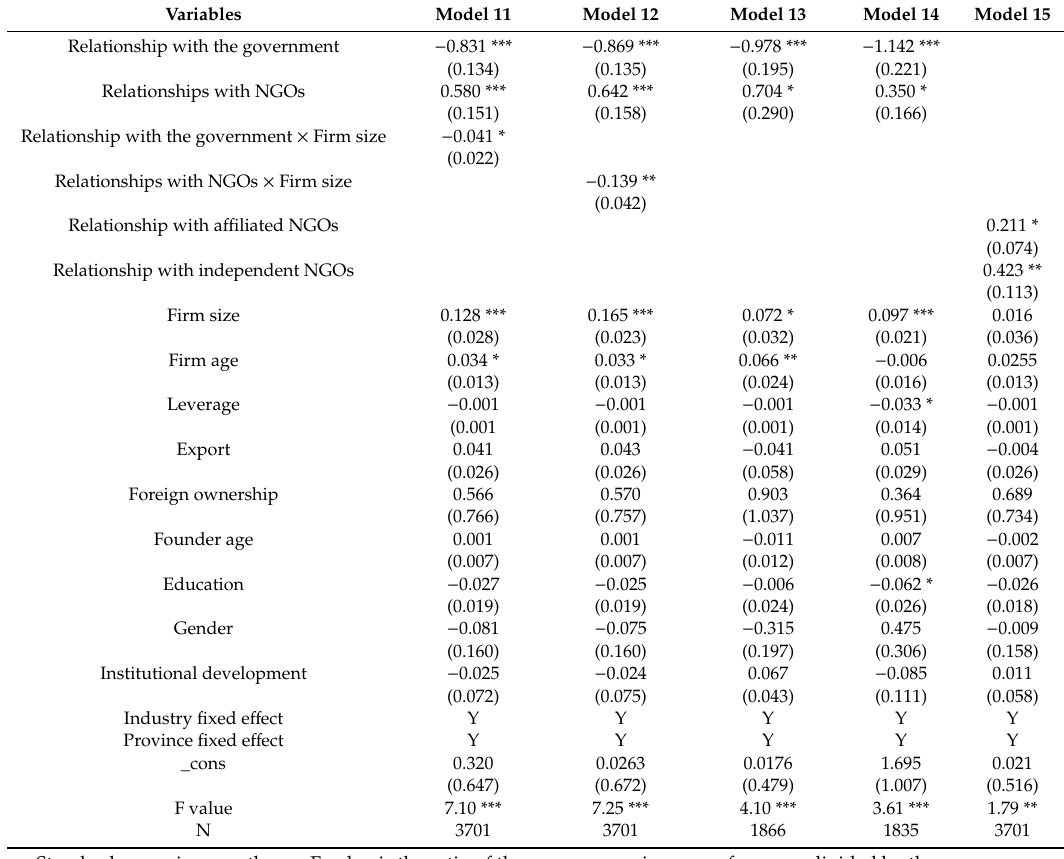
Table 5. Robustness check for moderating the e ff ect of firm